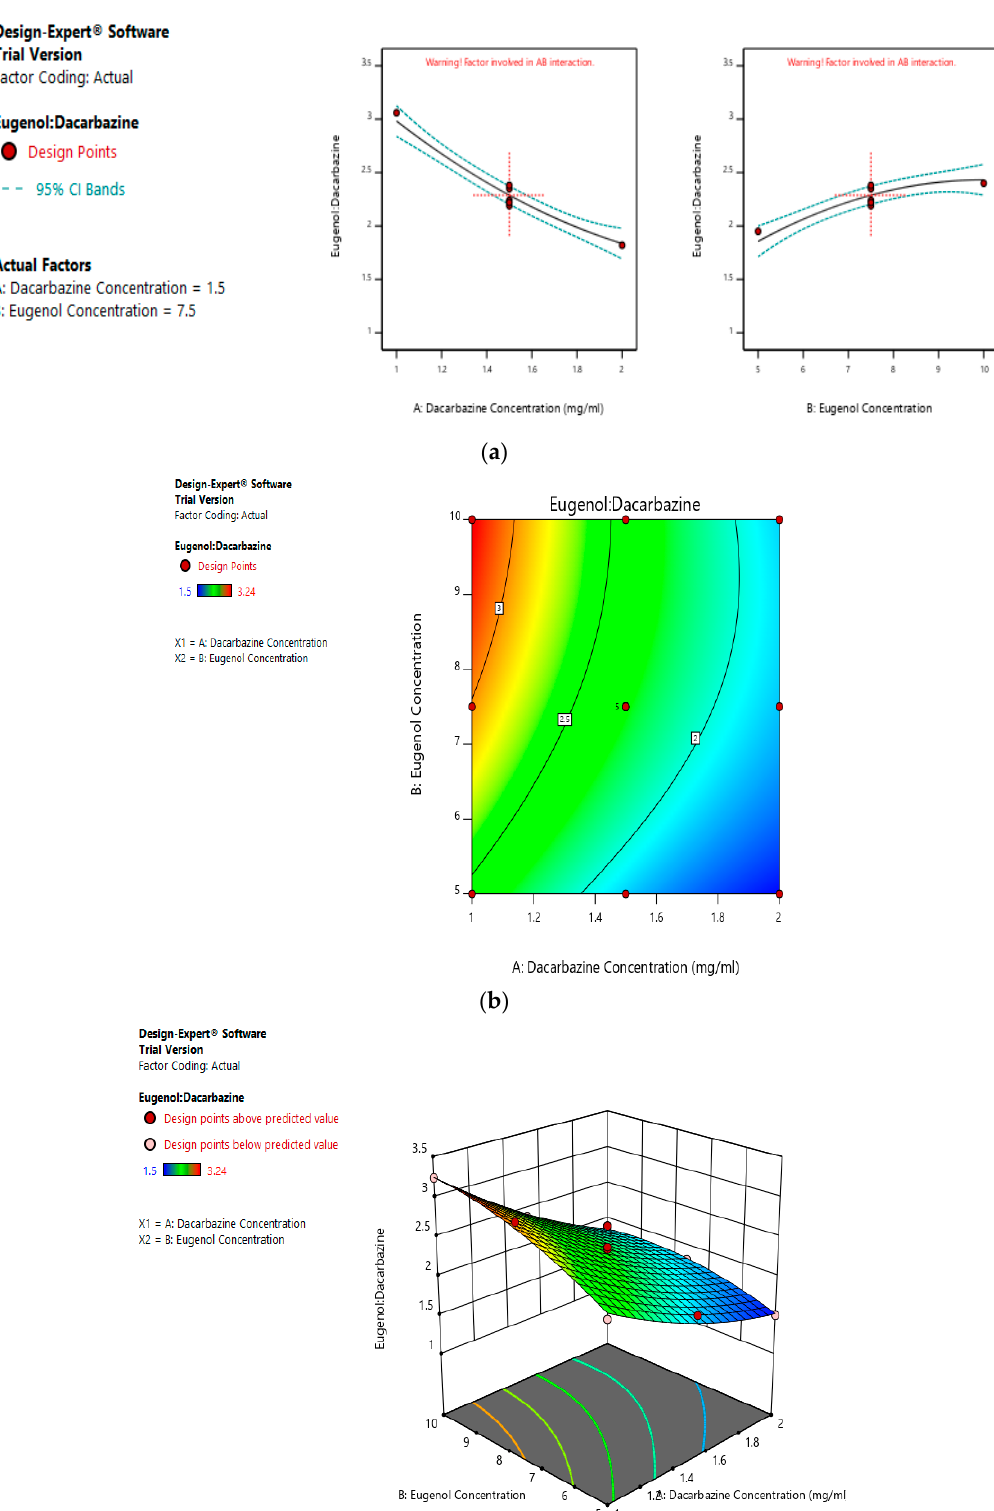
Figure 6. Effect of factors on Eugenol:Dacarbazine ratio of DEL ( a ) Effect of individual factors on Eugenol: Dacarbazine ratio of dual loaded liposomes; ( b ) Effect of combination of two factors on Eugenol: Dacarbazine ratio of dual loaded liposomes (2D plot); ( c ) Effect of Effect of combination of two factors on Eugenol:Dacarbazine ratio of dual loaded liposomes (3D plot).